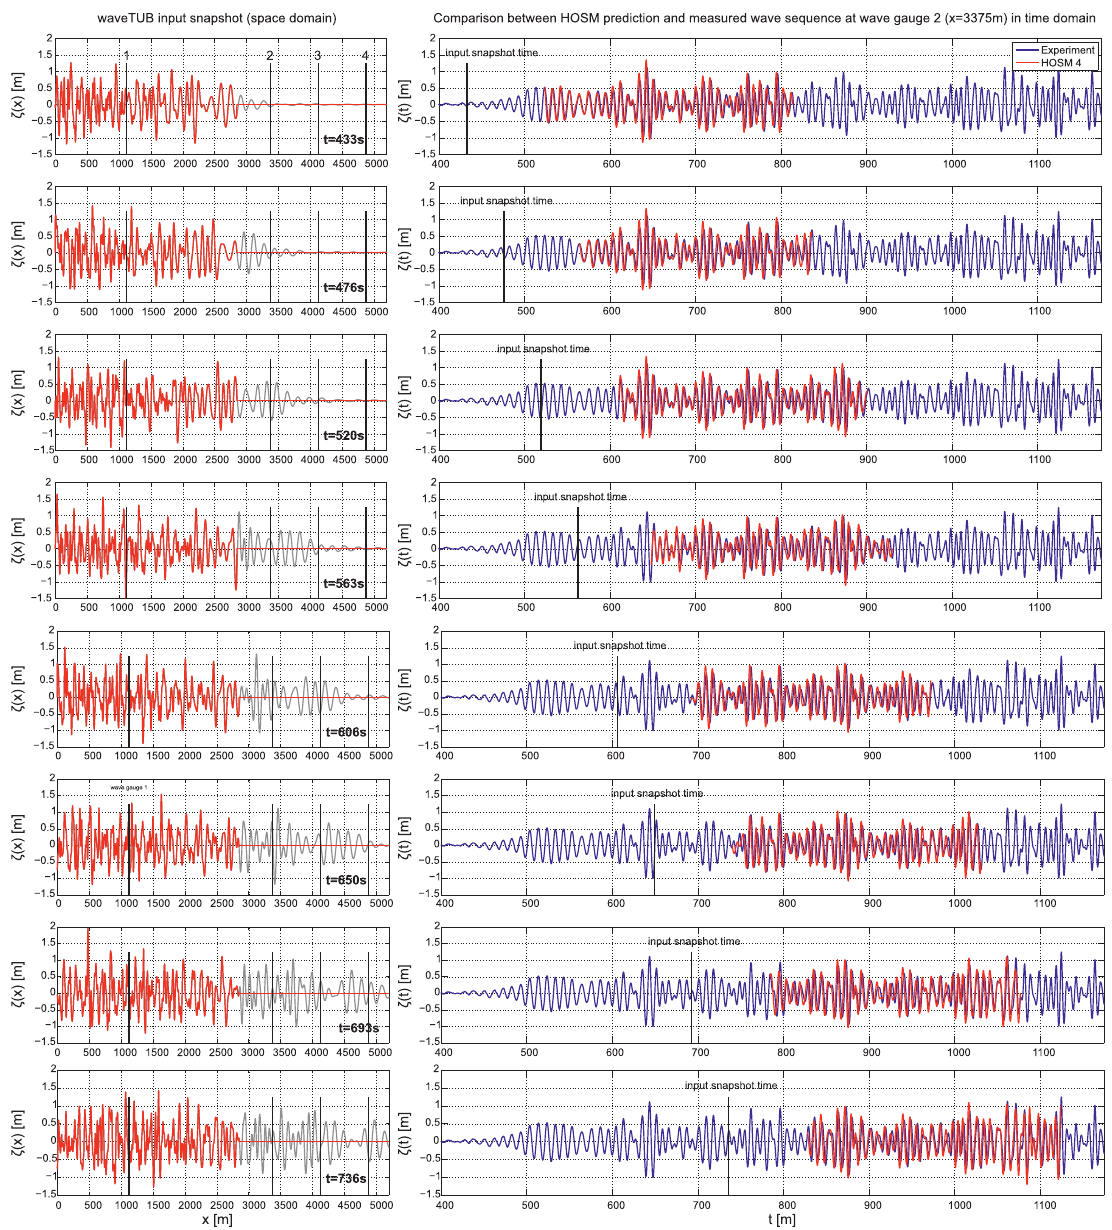
Figure 2. Detailed overview of the applied wave prediction procedure exemplary for sea state